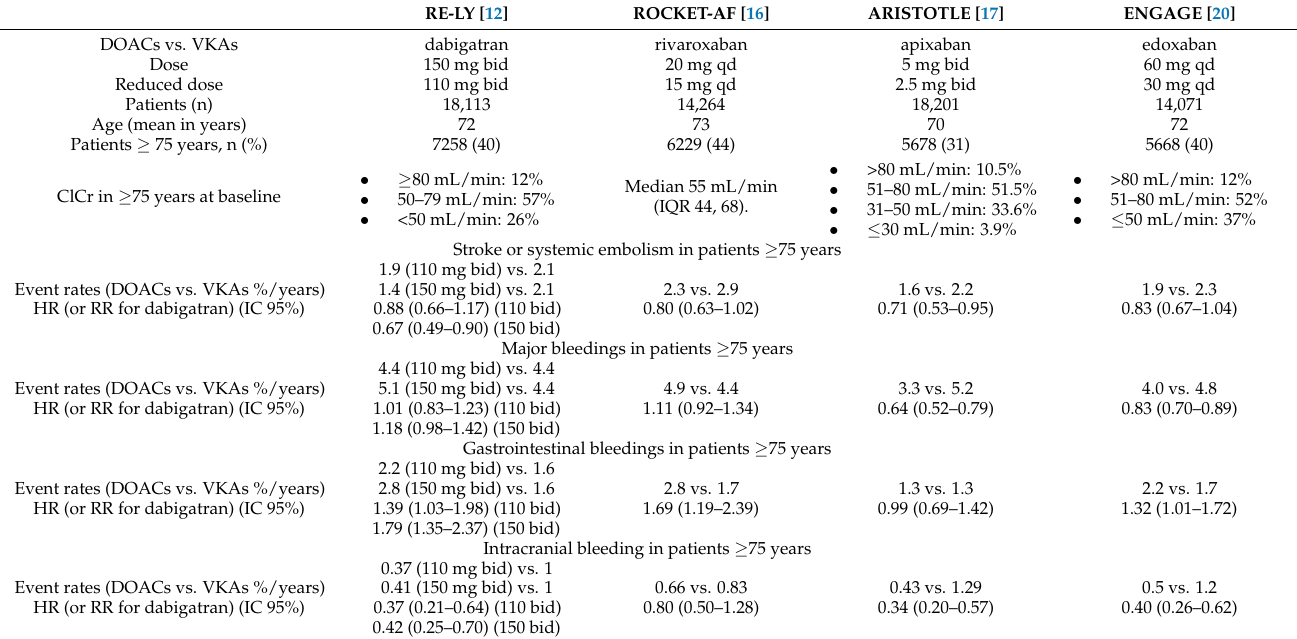
Table 1. Characteristics of DOAC principal trials and outcomes in patients aged ≥ 75